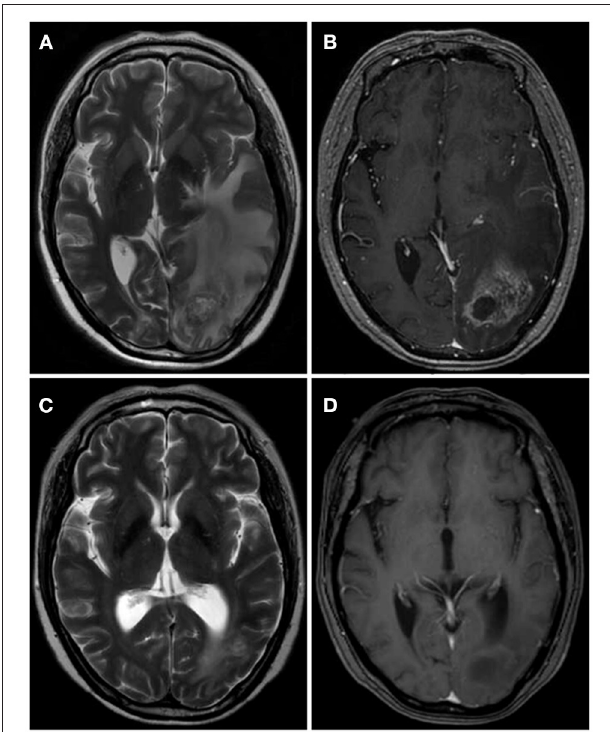
FIGURE 1 | One case of RN after Gamma Knife before and after bevacizumab treatment. (A,B) MRI showed the lesion was located in left occipital with large edema area and obvious enhancement surrounding the tumor. (C,D) After the therapy of bevacizumab (3 mg/kg) for 2 cycles, the zone of lesion reduced